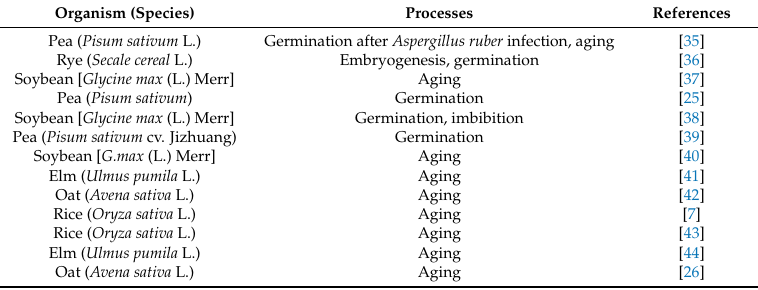
Table 1. The role of reactive oxygen species in dysfunction mitochondrion